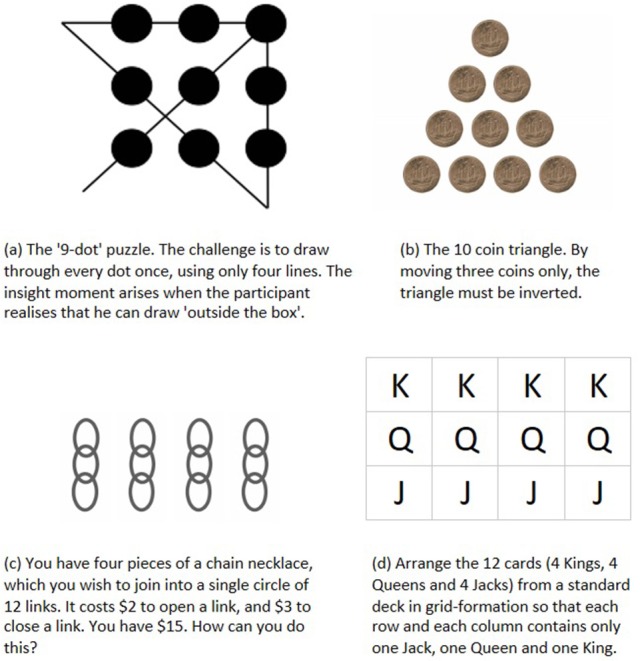
Classic brainteaser puzzles used to explore insight: see further Cunningham et al. (2009).